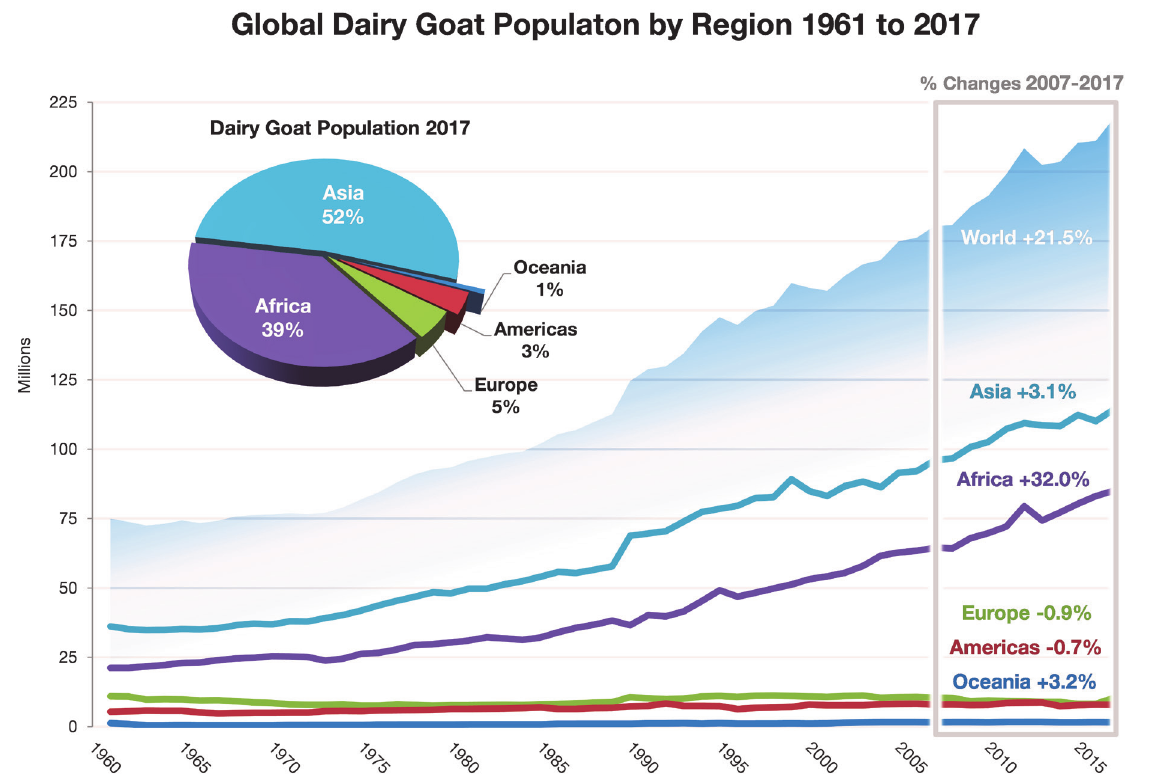
Figure 1. World dairy goat population (heads) during 1961 to 2017 (Compiled from [4], aggregated, may include official, semi-official, estimated or calculated